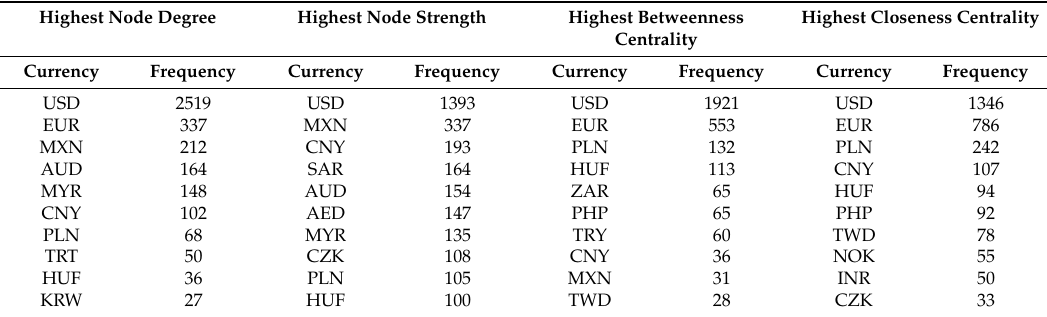
Table 2. Top 10 foreign exchange (FX) markets ranked by the highest centrality measures. Highest Node Degree Highest Node Strength Highest Betweenness Highest Closeness Centrality Centrality Currency Frequency Currency Frequency Currency Frequency Currency Frequency USD 2519 USD 1393 USD 1921